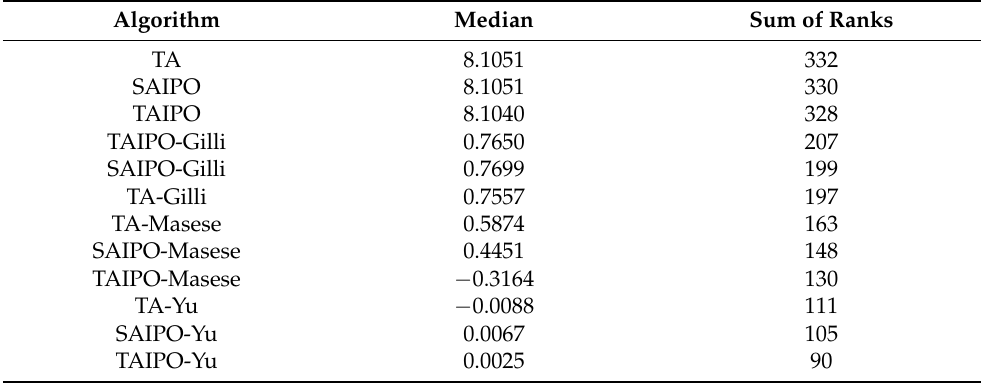
Table 6. Friedman Test TA, TAIPO and SAIPO Algorithms without MARR constraint.